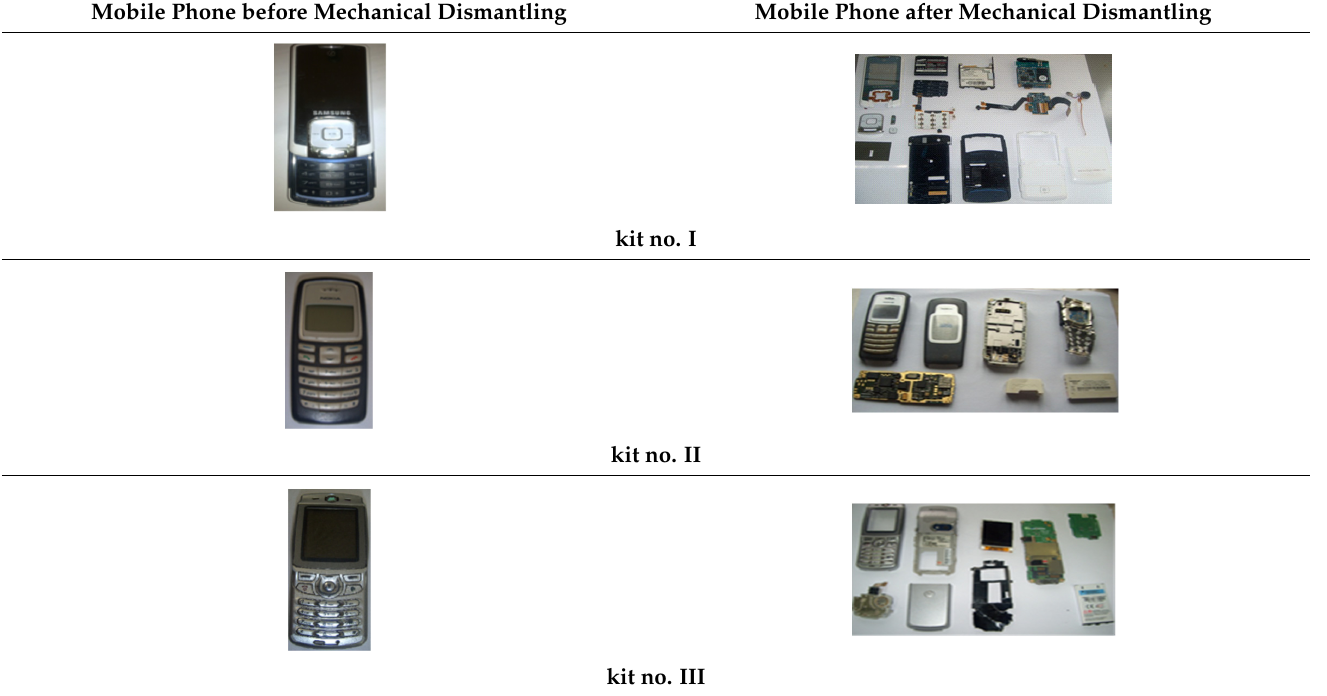
Table 1. Selected mobile phone waste before and after mechanical dismantling.